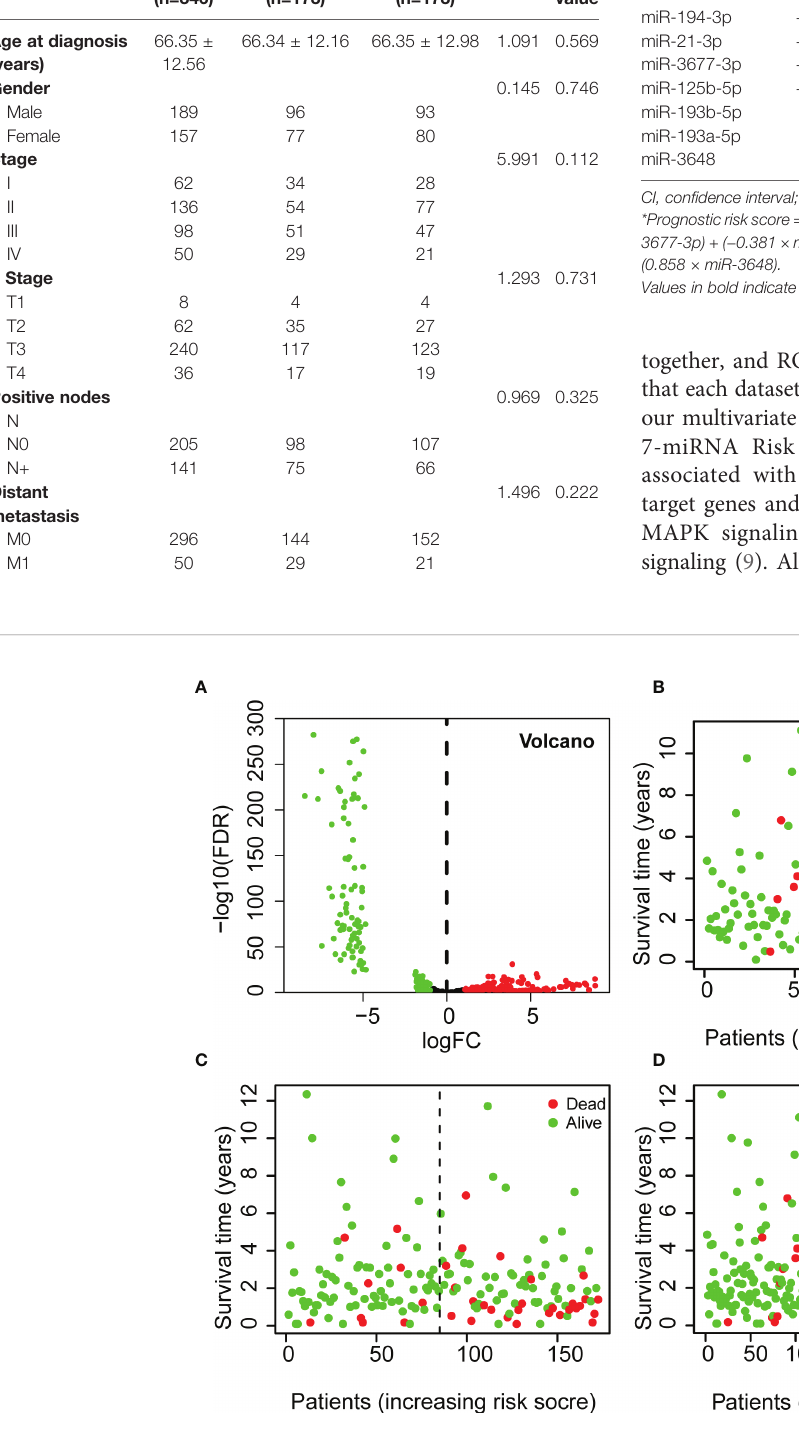
FIGURE 2 | Differential expression of miRNAs in patients with COADs (volcano plot) (A) and Using of the 7-miRNA Risk Score to predict survival status and survival time in the Training Set (B) , Testing Set (C) , and all patients (D) . A Red: up-regulated miRNAs [log 2 (FC) > 1.5, P < 0.05]; Green: down-regulated miRNAs [log 2 (FC) < 1.5, P < 0.05]. B – D Green: alive; red: dead; dotted vertical line: risk score curve separating the low-risk and high-risk groups. FC, fold-change.